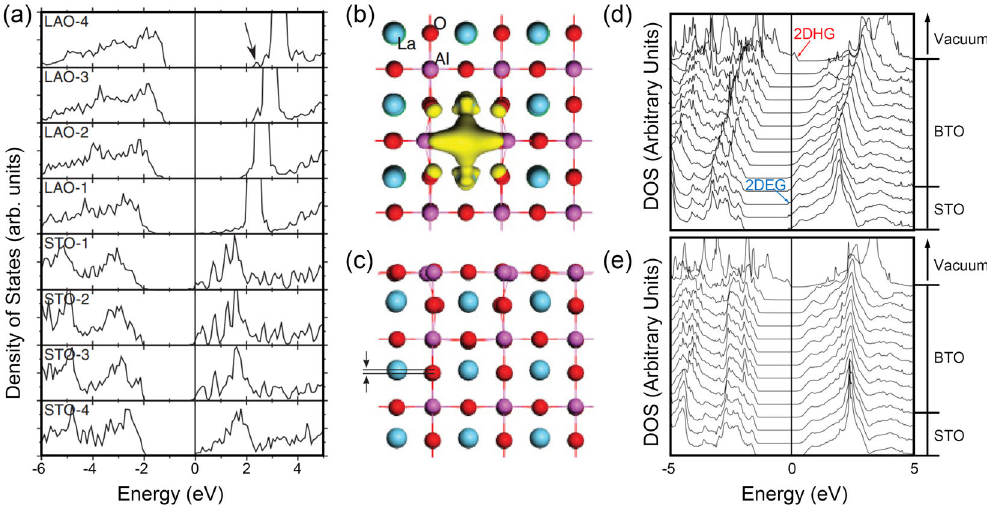
Fig. 2 Computational studies of the origin of the 2DEG at oxide interfaces. a The DFT calculation of the layer-projected DOS of (3 × 3) supercell with one oxygen vacancy on the LAO surface. The arrow points to the oxygen-vacancy state. b Top view of the spatial distribution of the oxygen-vacancy state at the surface. c Side view of the top three LAO layers. The arrows and horizontal lines denote the ionic displacement in LAO. Reproduced with permission from ref. 92 . Copyright [2011] {American Physical Society}. d , e Layer-projected DOS for ( d ) P + and ( e ) P 0 at a BTO/STO interface. Reproduced with permission from ref. 84 . Copyright [2015] {American Physical